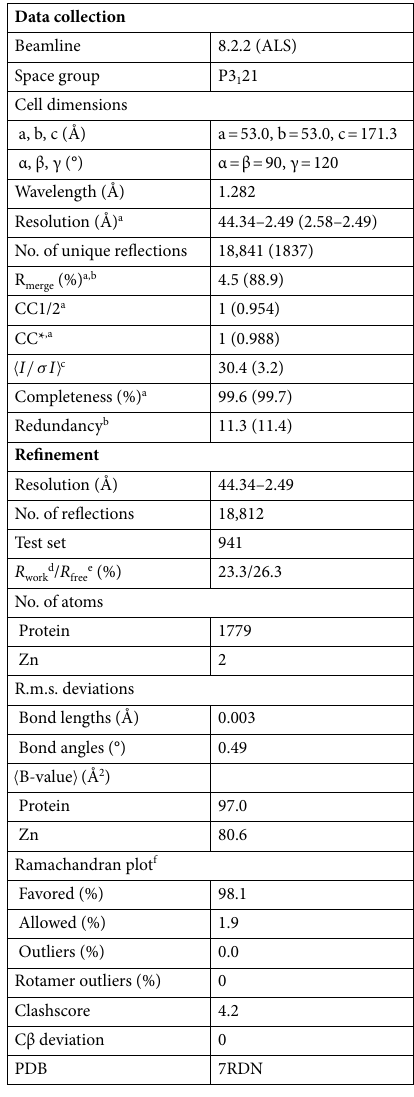
Table 1. Data collection and refinement statistics. a Highest-resolution shell is shown in parentheses. (cid:31) I (cid:30) | / ΣI, where I is the observed intensity and (cid:31) I (cid:30) is the averaged intensity from multiple b R merge = Σ | I − observations. c (cid:31) I /σ I (cid:30) = averaged ratio of the intensity (I) to the error of the intensity (σI). d R work = Σ | F obs − F cal | /Σ | F obs |, where F obs and F cal are the observed and calculated structure factors, respectively. e R free was calculated using a randomly chosen subset (5%) of the reflections not used in refinement. f As determined by